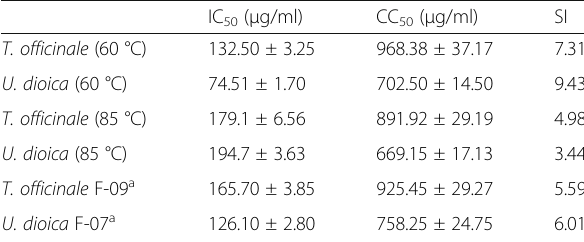
Table 3 Half maximal inhibitory concentration (IC 50 ) and selectivity index (SI) on DENV2 replication of methanolic extracts at 60 and 85 °C and the T. officinale and U. dioica fractions obtained by silica gel chromatography IC 50 ( μ g/ml)